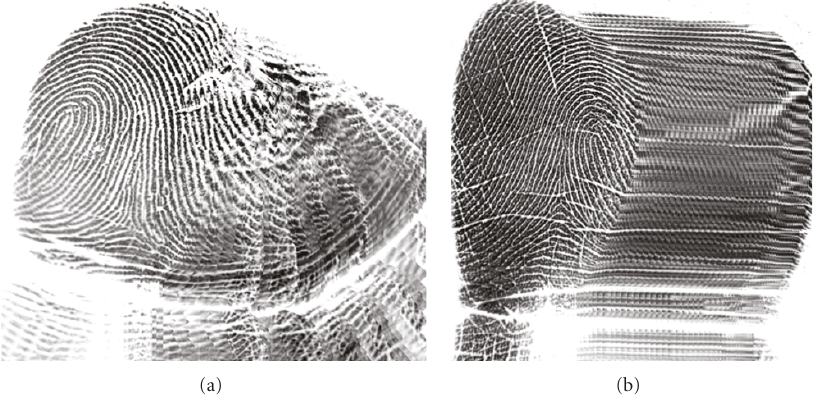
Figure 1: Defective fingerprint images with smears.